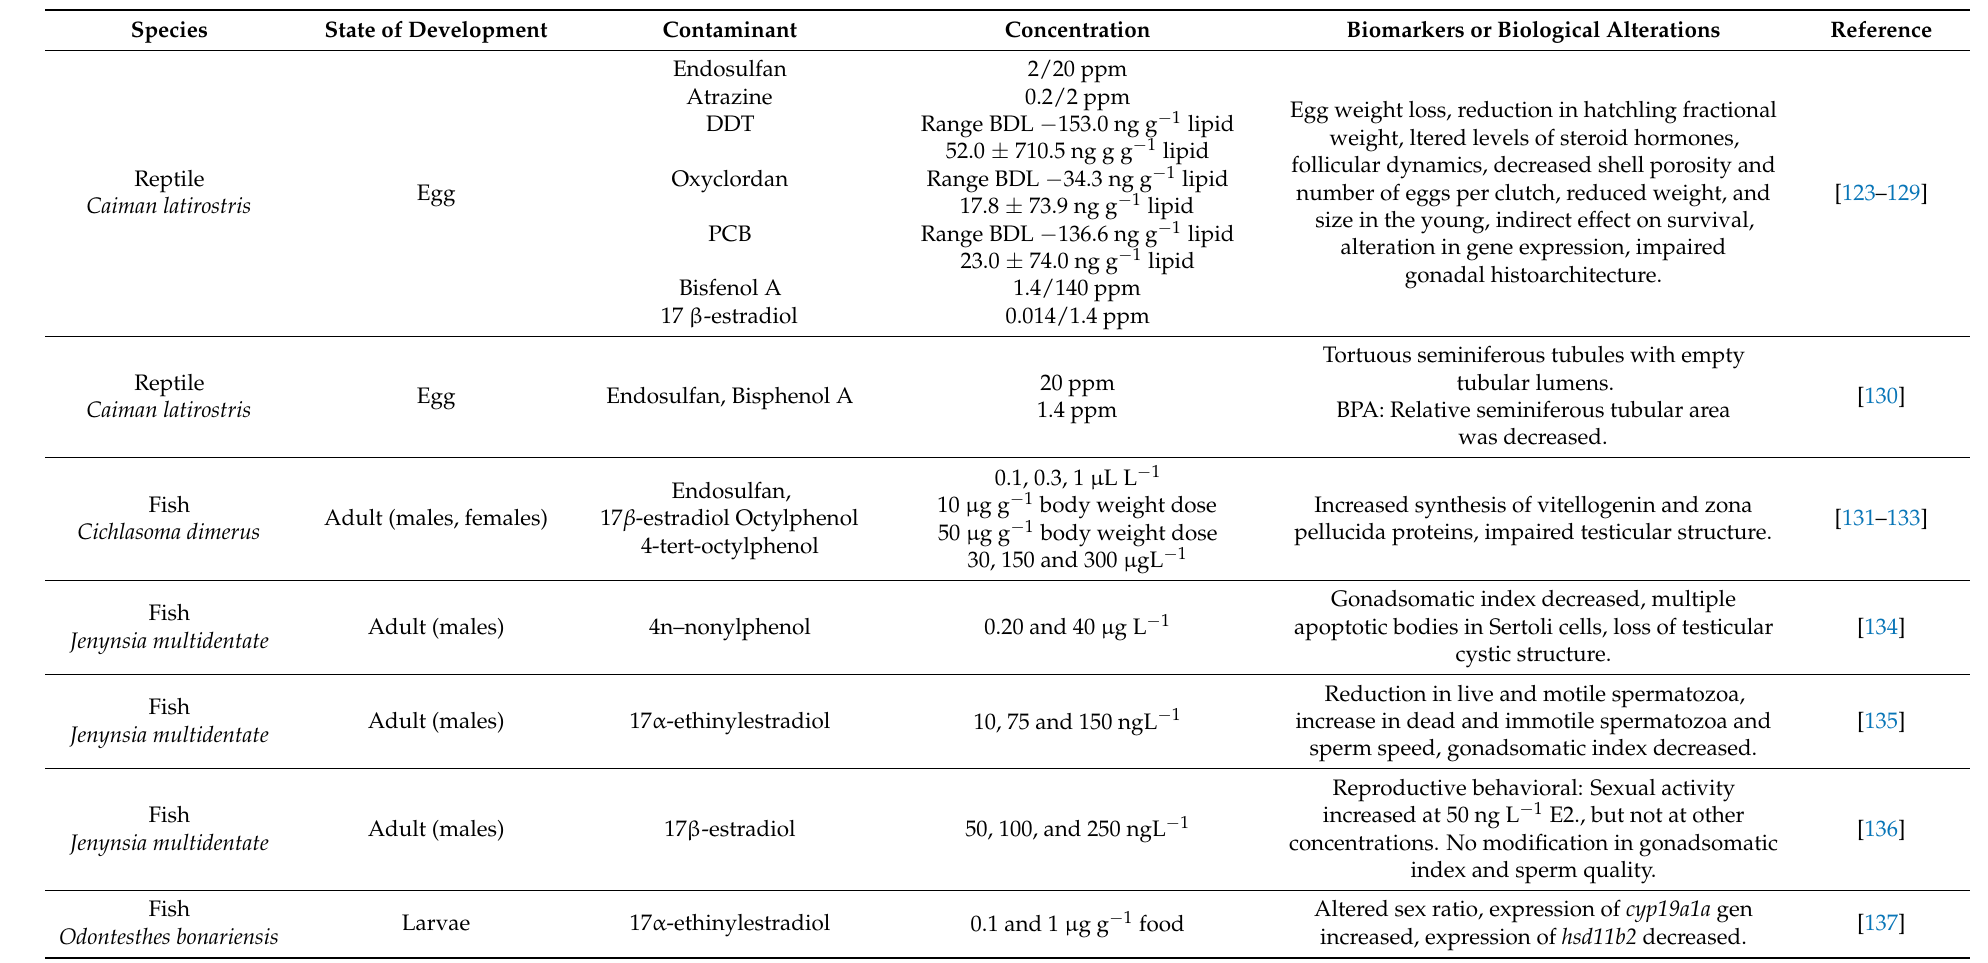
Table 2. Effects of endocrine disruptors under experimental conditions in Argentina by species, type of contaminant and biological responses.